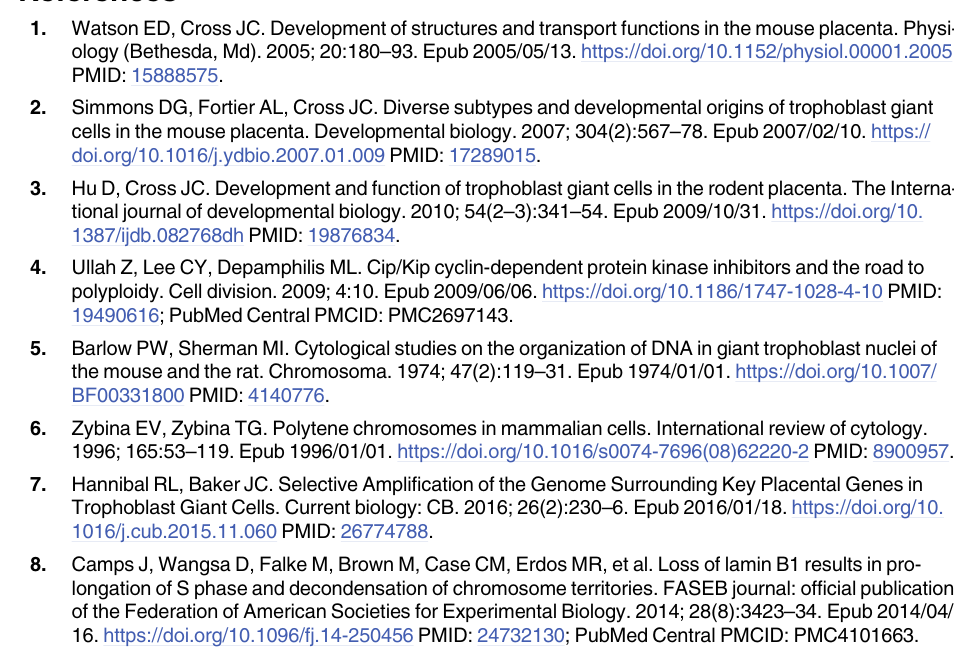
S5 Fig. Immunostaining of LMNB1 and cleaved caspase-3 as apoptotic marker. Cleaved caspase-3 was not detected in LMNB1-loss TGCs (arrowheads). To induce apoptosis, RO-3306 was added to NIH3T3 cells for 72 h at a final concentration of 10–5 M. Bars mean 20 μ m. S6 Fig. Expression analysis of Cts family genes. (A) RT-PCR analysis of Cts family genes. (B) Western blot analysis of CTSL protein in TS cells after differentiation. Mature CTSL increased dramatically from day 6 after